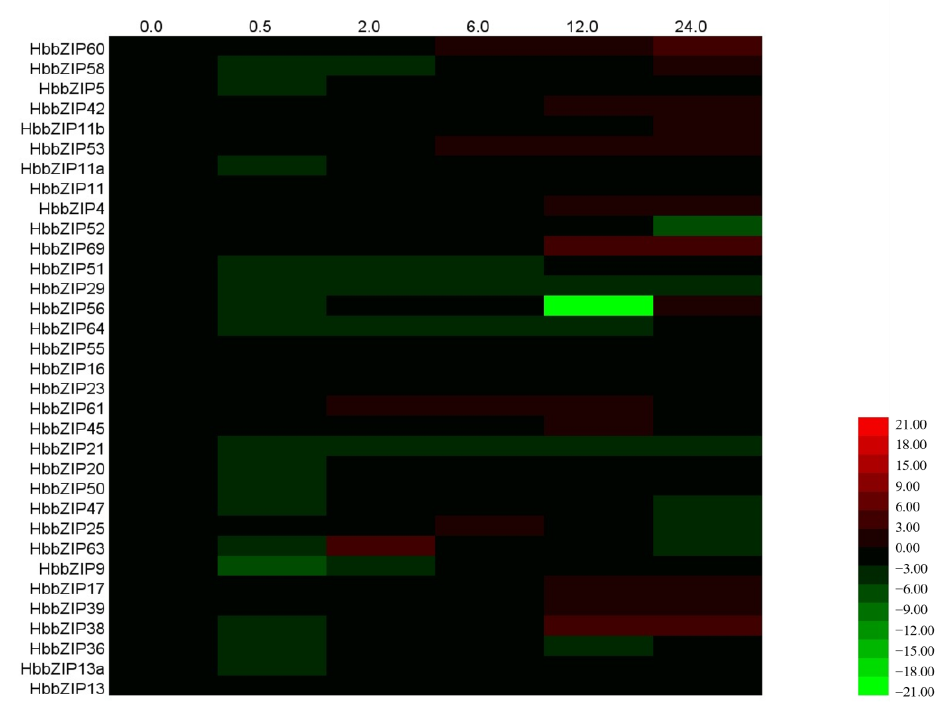
Figure 5. Expression of 33 HbbZIPs in rubber trees in response to ABA treatment. For biotic stress, we analyzed the expression of HbbZIP s in rubber tree leaves for 0–24 h after powdery mildew infection. The results showed that HbbZIP s were differentially expressed after powdery mildew infection. For example, HbbZIP 60 in the B subgroup, HbbZIP 11 in the S subgroup and HbbZIP 13 and HbbZIP 13 a in the A subgroup were significantly upregulated by approximately 15–21-fold. In contrast, HbbZIP 4 in the S subgroup and HbbZIP 47 in the D subgroup were significantly downregulated (Figure 6). We also analyzed the expression of HbbZIP s in rubber tree leaves at 24 h after glyphosate treatment. The expression fold change for all genes of subgroup A in response to glyphosate increased at 0 h at 12 h, although the expression of HbbZIP 38 was downregulated. The B subgroup HbbZIP 17 gene was upregulated in response to glyphosate treatment. At 0.5–12 h after glyphosate treatment, the levels increased by approximately 10-fold. Notably, in the C subgroup, the HbbZIP 25 gene was not expressed, and in the D subgroup, HbbZIP 9 and HbbZIP 63 were expressed at 0 h and 24 h after glyphosate, and HbbZIP 47 was upregulated at 24 h (15.5-fold increase in expression). The E subgroup gene HbbZIP 61 was upregulated after glyphosate treatment, and the gene expression fold change decreased to almost 0 at 24 h. The HbbZIP 55 and HbbZIP 16 genes of the G subgroup were upregulated in response to glyphosate, whereas the HbbZIP 56 and HbbZIP 64 genes in the H subgroup were barely expressed at 24 h. Several genes other than HbbZIP 29 in the I subgroup were also upregulated in response to glyphosate until the expression fold change nearly peaked, which occurred at 6 h after treatment. The S subgroup genes HbbZIP 53, HbbZIP 4, HbbZIP 58 and HbbZIP 5 were upregulated in response to glyphosate after 0.5–12 h, and the HbbZIP 42 gene was also upregulated at 12 h after glyphosate treatment, with a 12-fold maximum expression fold change (Figure 7).